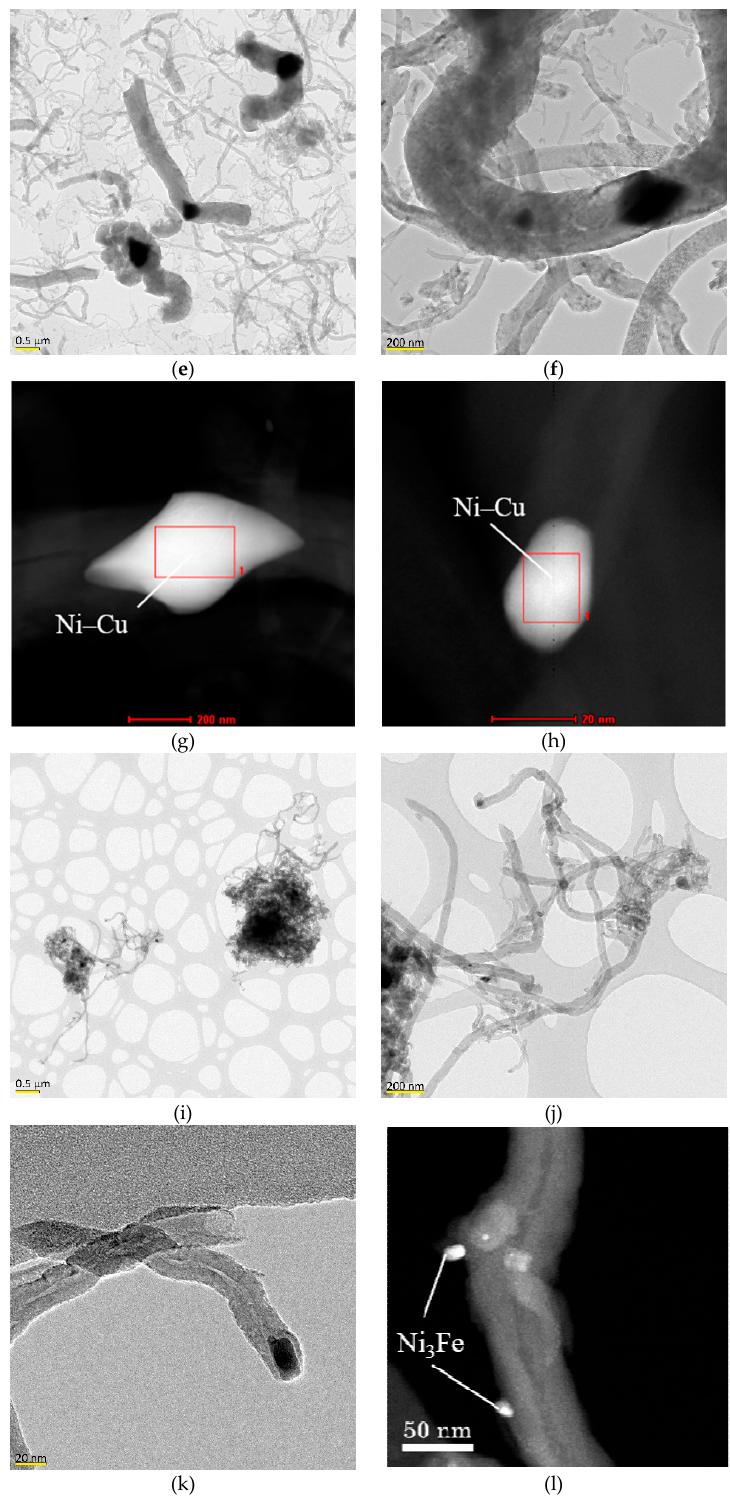
Figure 9. TEM and STEM images of CNF obtained on ( a – d ) Ni–Co/Al; ( e – h ) Ni–Cu/Al; and ( i – l ) Ni–Fe/Al catalysts. CDM was carried out in a quartz FBR for 120 min with an operating temperature of 650 °C.